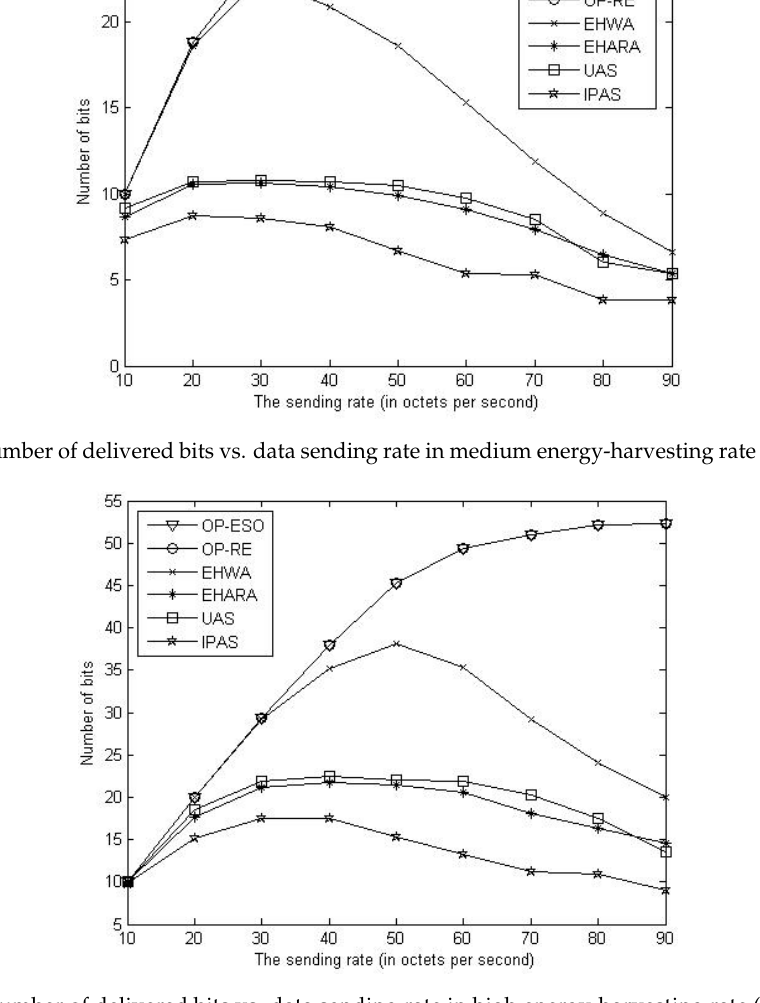
Figure 7. Number of delivered bits vs. data sending rate in high energy-harvesting rate (HER) case.